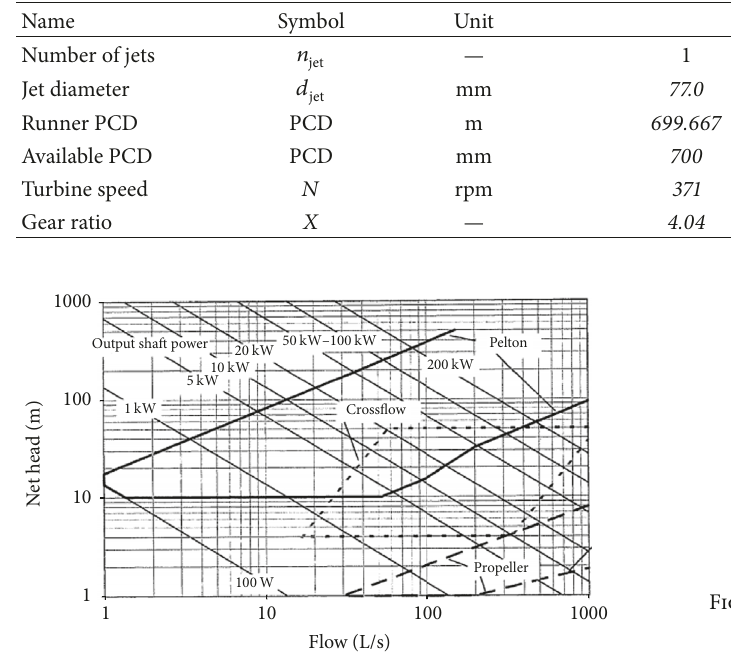
Figure 2: Application ranges for different types of turbine [6].